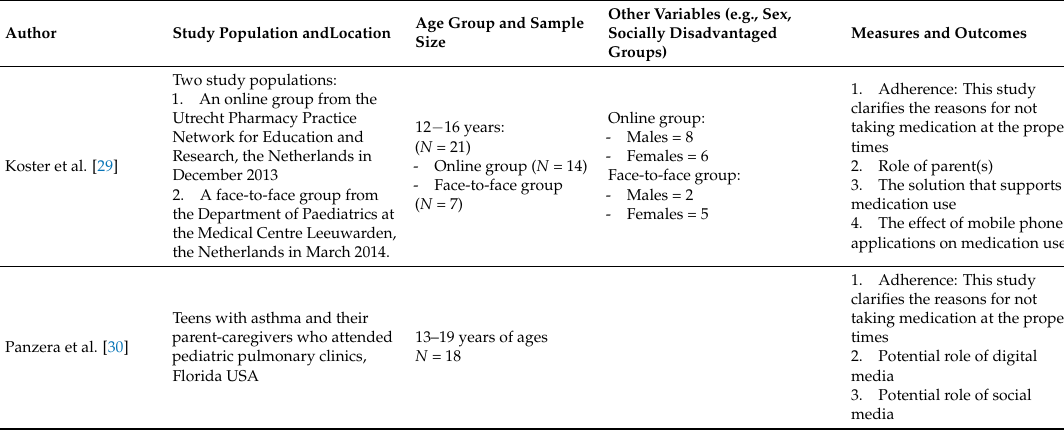
Table 5. Characteristics of the qualitative